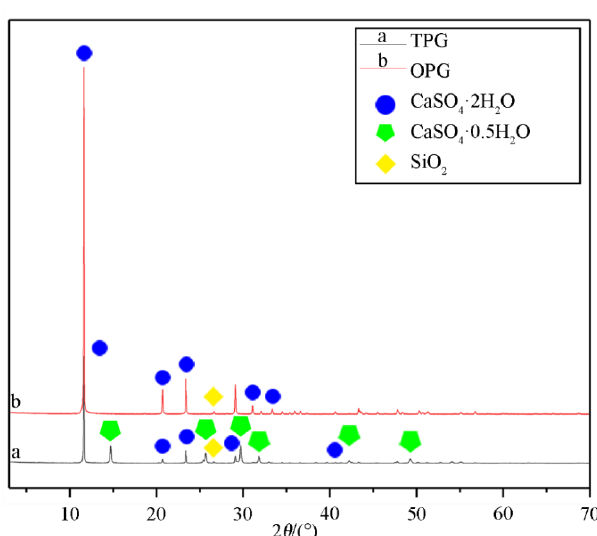
Figure 7. X-ray diffraction (XRD) patterns of OPG and TPG.